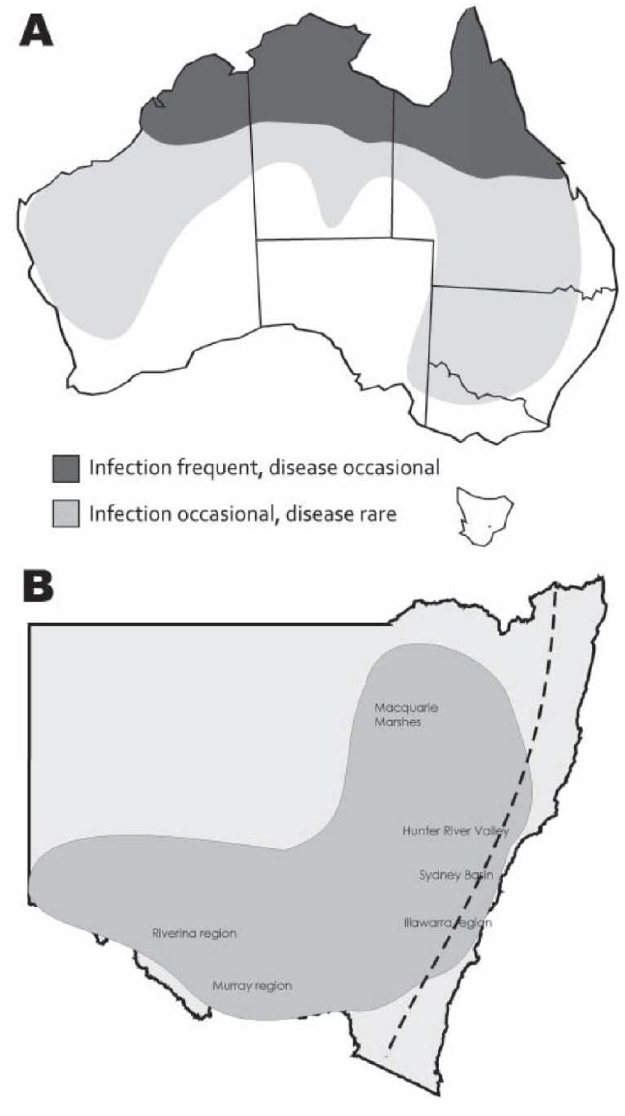
Figure 2. Historical distribution of WNV in Australia ( A ). Distribution of encephalitic KUN horse cases in NSW during the 2011 outbreak ( B ). Dashed line indicates the Great Dividing Range. Adapted from